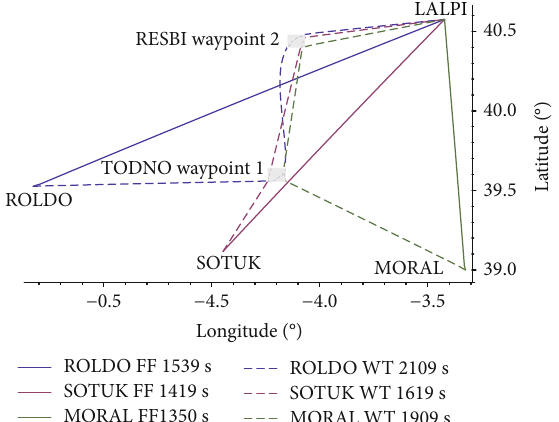
and without (FF, solid lines) waypoints and time-based separation constraints.